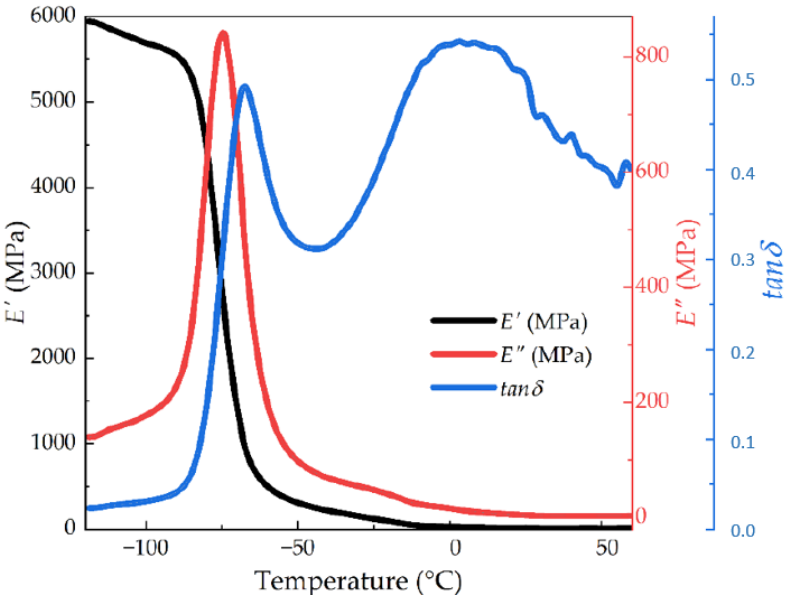
Figure 5. Storage modulus ( E ′ ), loss modulus ( E ″ ) and loss factor ( tan δ ) as a function of temperature for the SP-PP propellant ( f = 1 Hz).